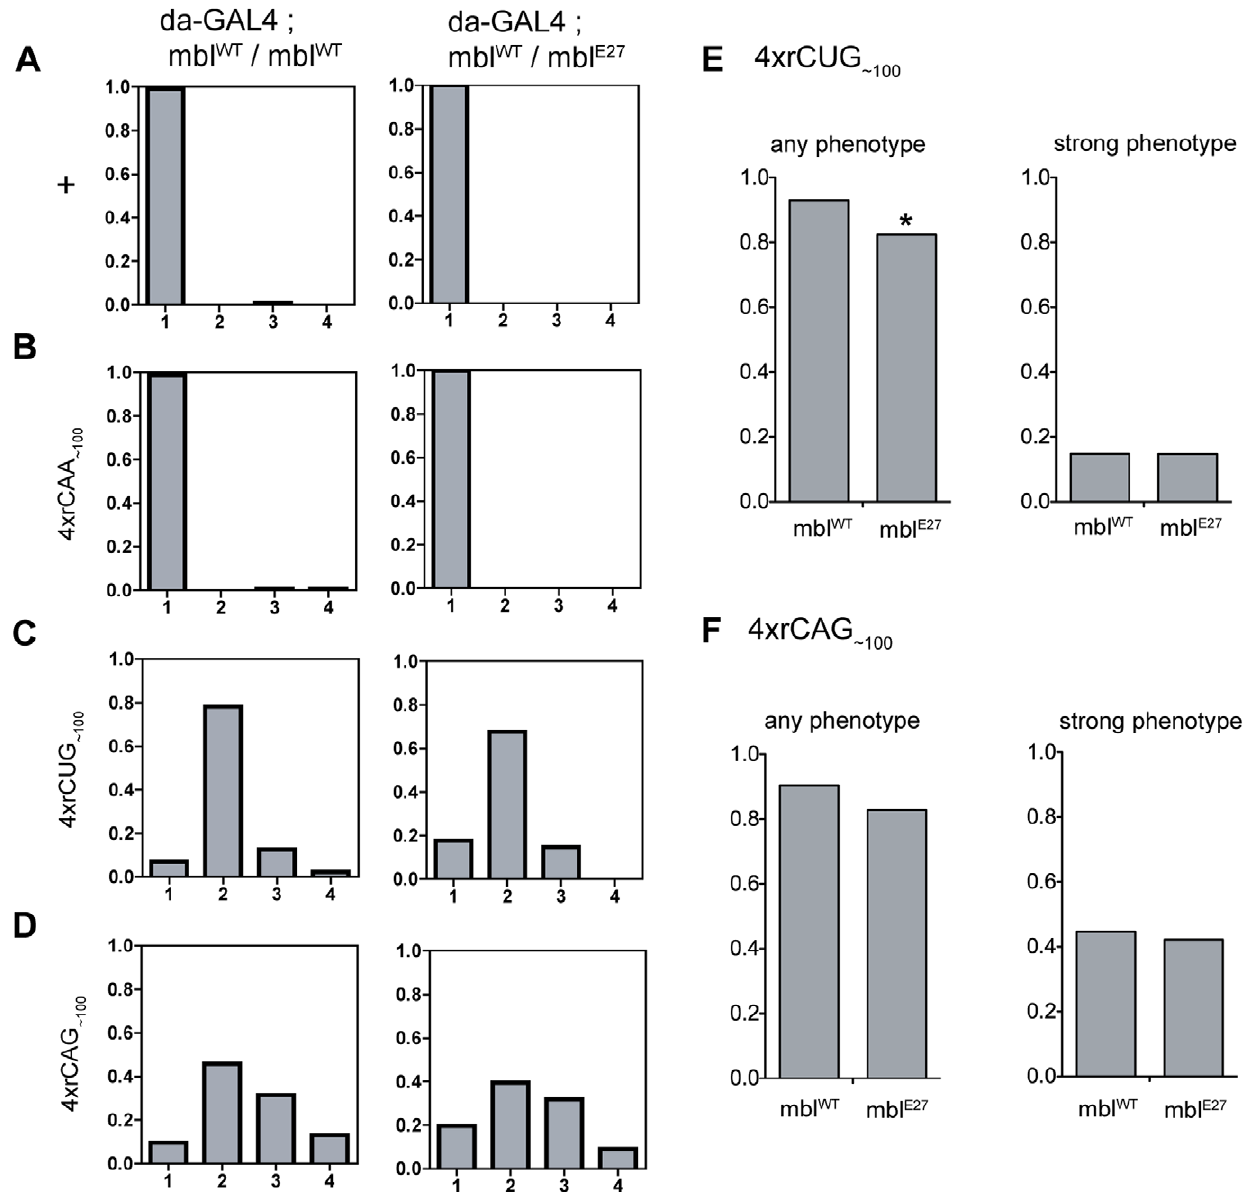
Figure 2. Reducing Mbl levels does not enhance the tergite phenotype. A-D , Proportion of progeny within each phenotype category when repeat expression is driven by da-GAL4 alone (left column), or in the presence of the mbl E27 mutant allele such that Mbl levels are reduced (right column). A , Wild-type control, B , 4xrCAA , 100 [line 1] , C , 4xrCUG , 100 [line 1] , D , 4xrCAG , 100 [line 2] . E, F , Total proportion for each genotype that shows any phenotype (‘any phenotype’ - category 2, 3 and 4) and the proportion with a strong phenotype (‘strong phenotype’ – category 3 and 4). E , 4xrCUG , 100 [line 1] shows a reduction in the proportion with any phenotype, but no change in the proportion with a strong phenotype with reduced Mbl levels. F , No significant effect was observed with 4xrCAG , 100 [line 2] . Comparisons were made using Fisher’s exact test, with significant results indicated above the proportion, where *p , 0.05. the Dcr-2 L811fsX mutant allele did not give a significantly different phenotype severity compared to repeat RNA expression in a wild-type Dcr-2 background (Figure 3E, F, S4 and Table S7). Thus, a reduction in Dcr-2 levels is not rate limiting for CAG or